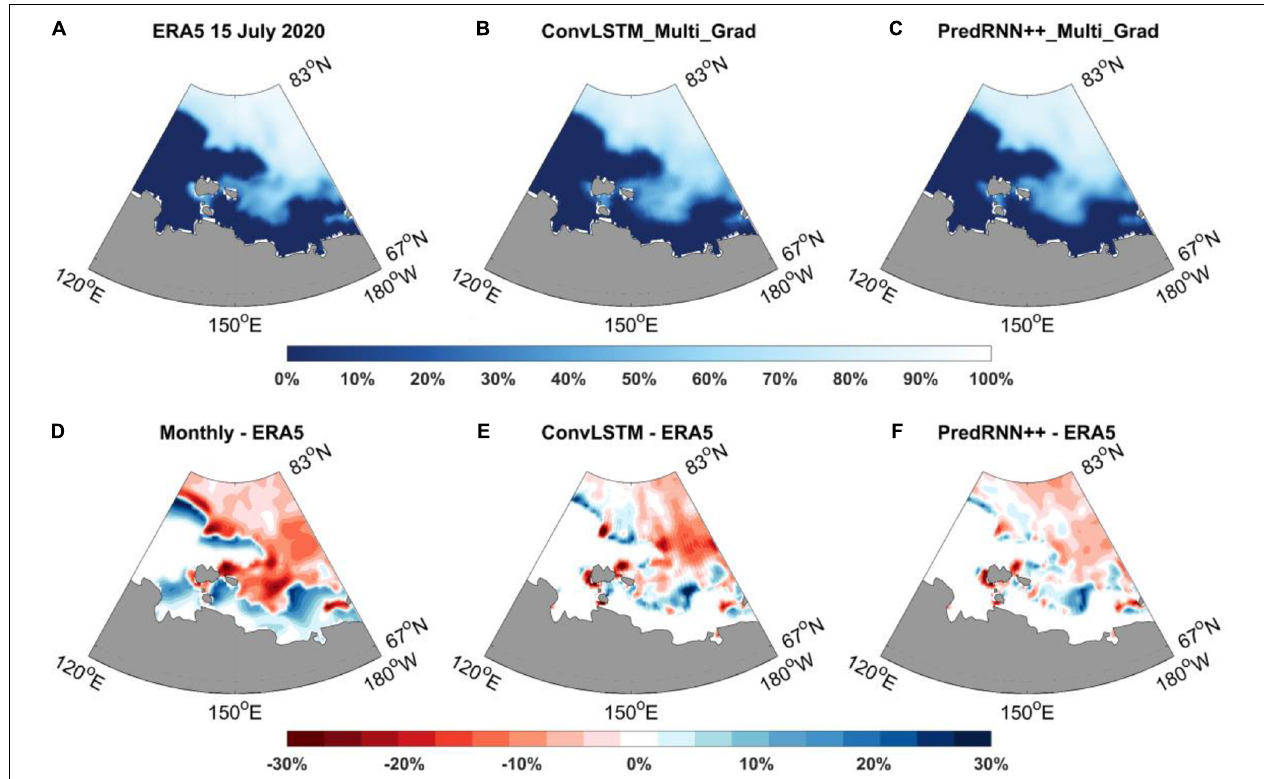
FIGURE 11 | The SIC of ERA5 in the East Siberian Sea on 15 July 2020 (A) . The SIC predicted by ConvLSTM on 15 July (B) . The SIC predicted by PredRNN++ on 15 July (C) . The DIFF of the monthly average SIC minus (A) in July (D) . The DIFF of the (B) minus (A,E) . The DIFF of the (C) minus (A,F) .